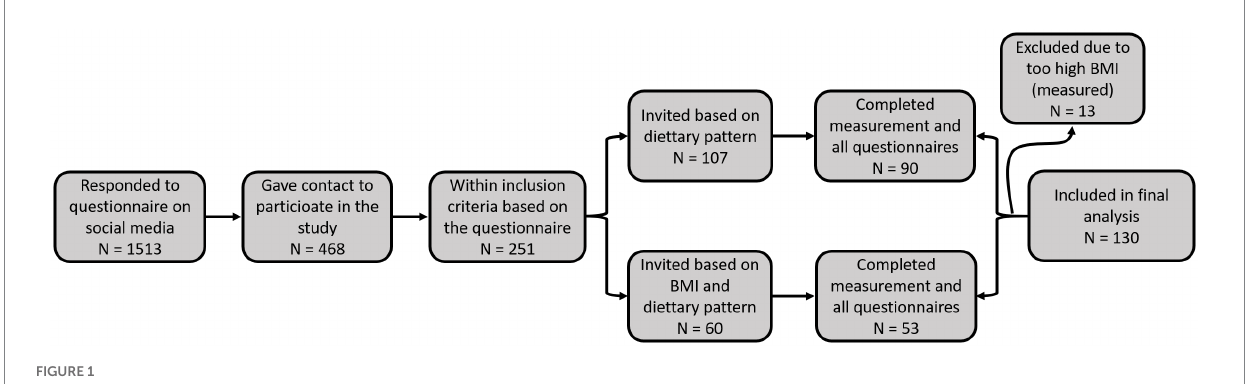
FIGURE 1 Flow diagram of the recruitment